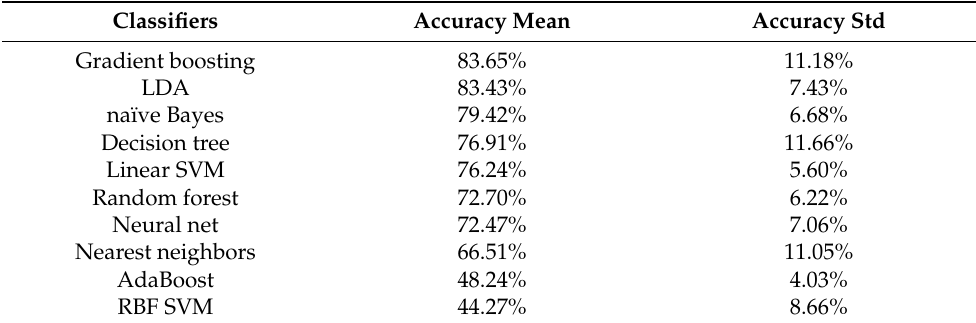
Table 5. Cross-validation results for all features.